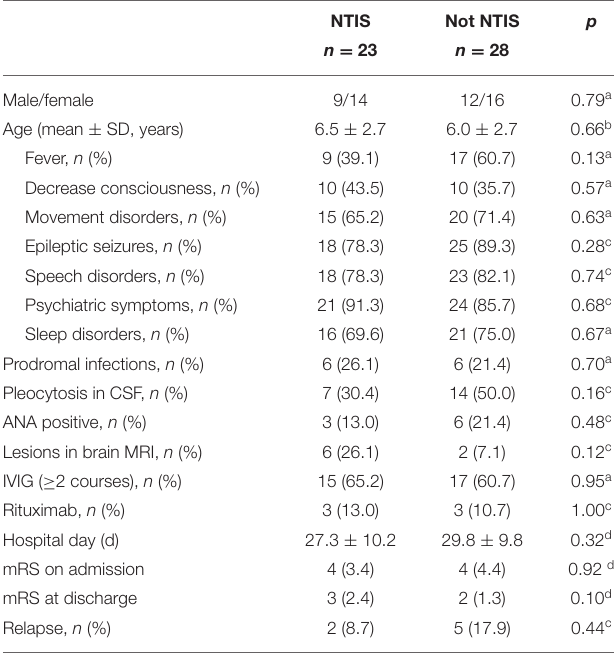
TABLE 3 | Comparison of clinical characteristics between NTIS and not NTIS group.